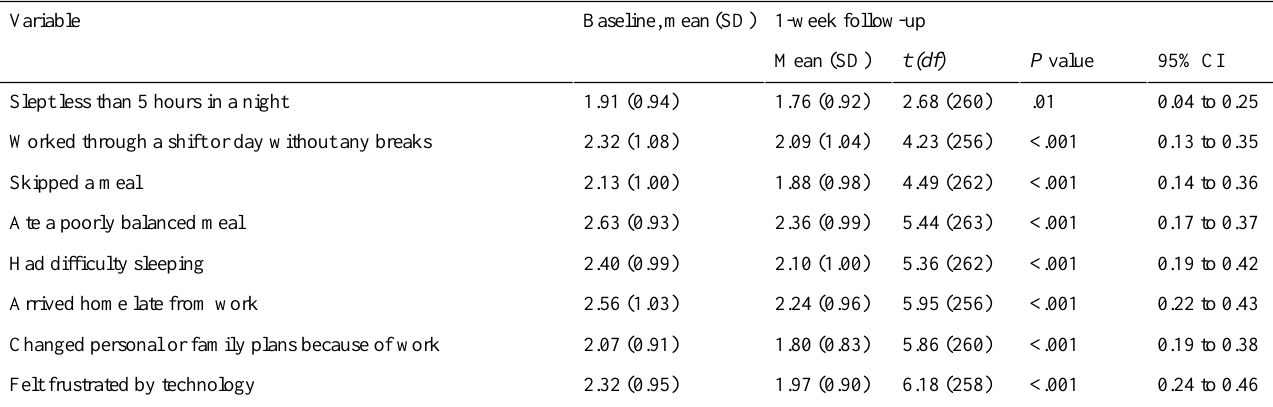
Table 4. Paired-samples t tests assessing work-life balance items across participants who completed the 1-week follow-up gratitude letter–writing